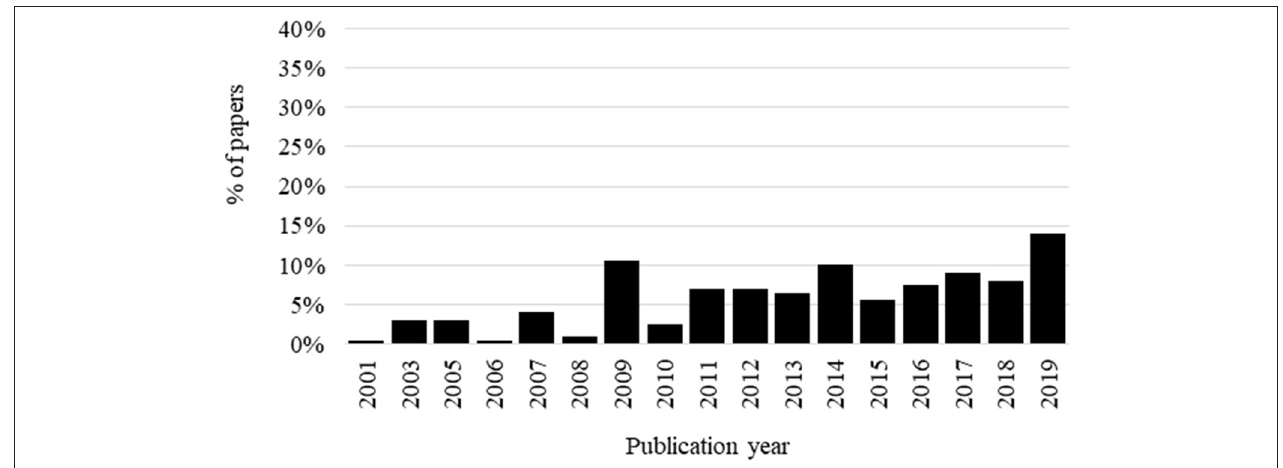
FIGURE 2 | Percentage of papers including a general animal-based measures codified term according to the publication year.